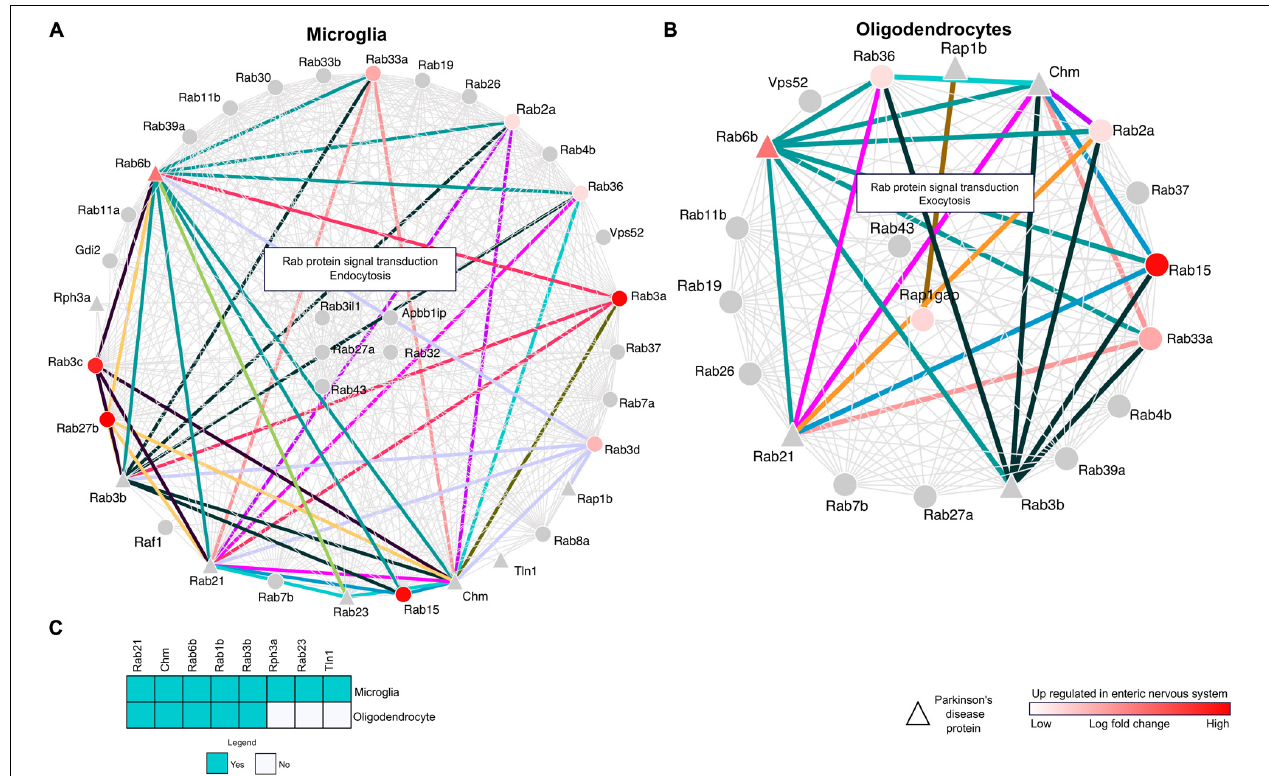
FIGURE 4 | Cell-type-specific and enteric nervous system (ENS) protein interactions. (A,B) Network maps representing the RRi and pathways regulated in microglia and oligodendrocytes. Note: red color denotes upregulation of a protein in the ENS. Triangle shape nodes indicate Parkinson’s disease (PD)-related proteins. Colored lines denote the interactions between the PD and ENS proteins. (C) The heatmap represents the PD proteins between the microglia and